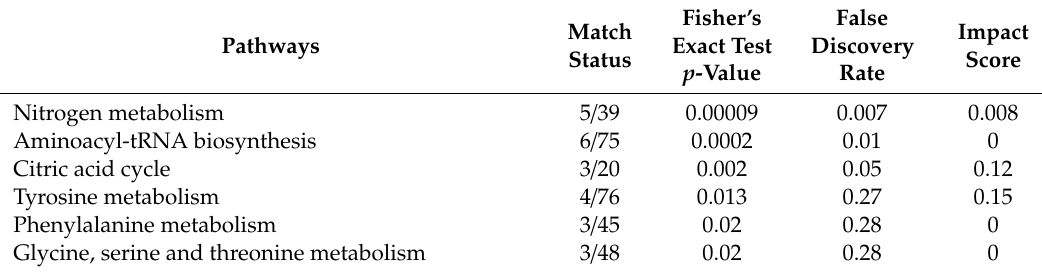
Table 3. Top results from a pathway analysis of 35 top metabolites 1 correlated with scores on the Scale of Aging Vigor in Epidemiology (SAVE; p < 0.05) among 287 black men from the Health, Aging, and Body Composition